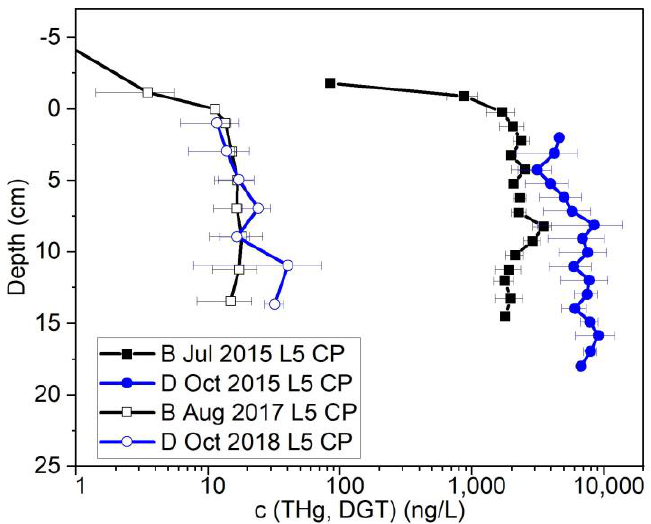
Figure 7. Porewater THg concentration measured by DGT in L5 at Constitution Park during differ- ent sampling events both before and after bank stabilization under baseline (B) and drainage conditions (D); on the y-axis, 0 represents the water/sediment interface and the negative numbers refer to distances above the interface (i.e., in the water column).